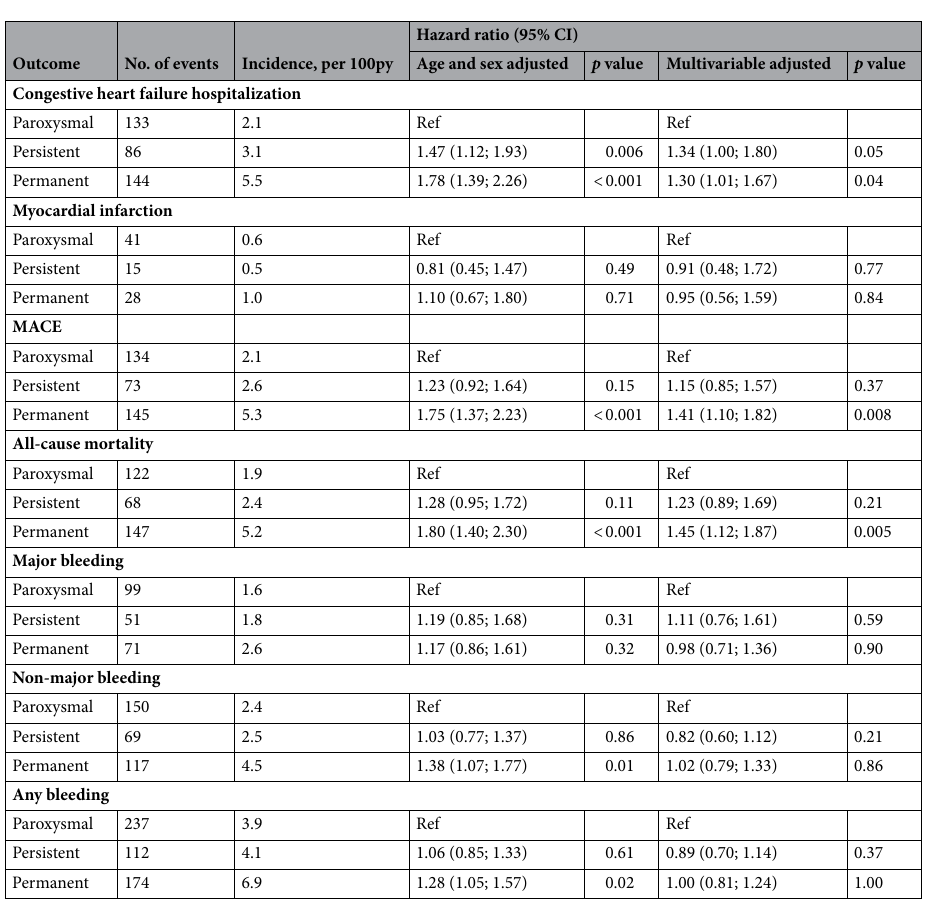
Table 3. Risk of secondary endpoints according to atrial fibrillation type. Data are hazard ratios (HR) (95% confidence intervals [CI]). p-values were based on Cox regression models. No. number, Ref. reference, py patient years, MACE major adverse cardiovascular event (Ischaemic stroke/myocardial infarction/ cardiovascular death). P-values are based on Cox regression models. Multivariable models were adjusted for age, sex, heart rate and time-updated: smoking status (current vs. history/never smoker), BMI, history of diabetes, history of coronary artery disease, history of hypertension, history of heart failure, history of stroke and/or transient ischemic attack, history of renal failure, oral anticoagulation, antiplatelet therapy, history of pulmonary vein isolation and history of electrical